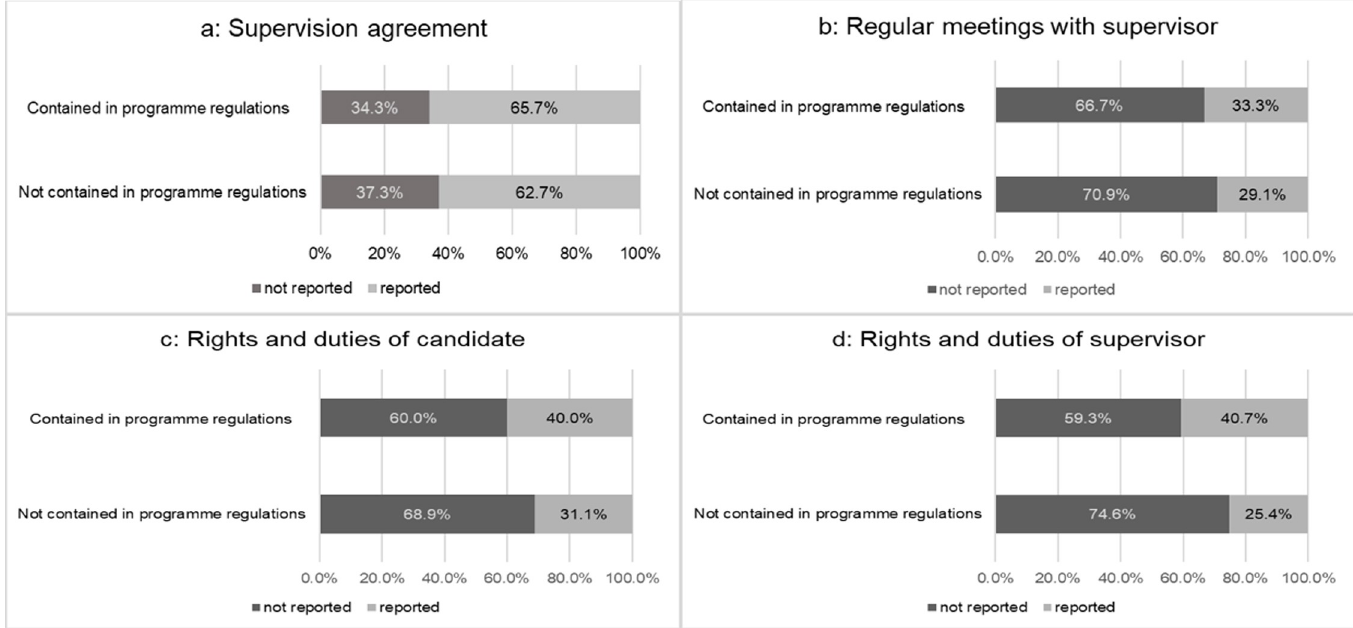
Fig 3. Discrepancy between doctoral regulations of structured doctoral programmes ( N = 94) and regulatory practice as reported by graduates of structured doctoral programmes. a F = 0.03, p = 0.778; b F = 0.045, p = 0.661; c F = 0.078, p = 0.452; d F = 0.152, p = 0.140.